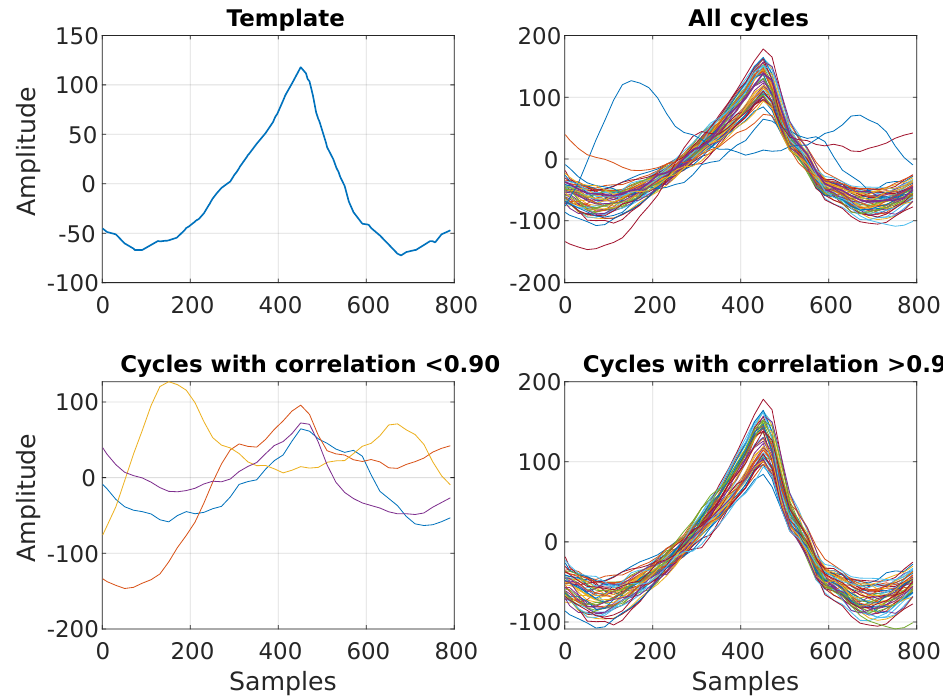
Figure 5. Matched filtering of PPG cycles. ( Top left ) Exemplar template used for matched fil- tering of PPG cycles. ( Top right ) Overlay plot of all PPG cycles acquired during one recording. ( Bottom left ) Exemplar low − quality PPG cycles, with a correlation < 0.9 with the template. ( Bottom right ) Overlay plot of the remaining PPG cycles after matched